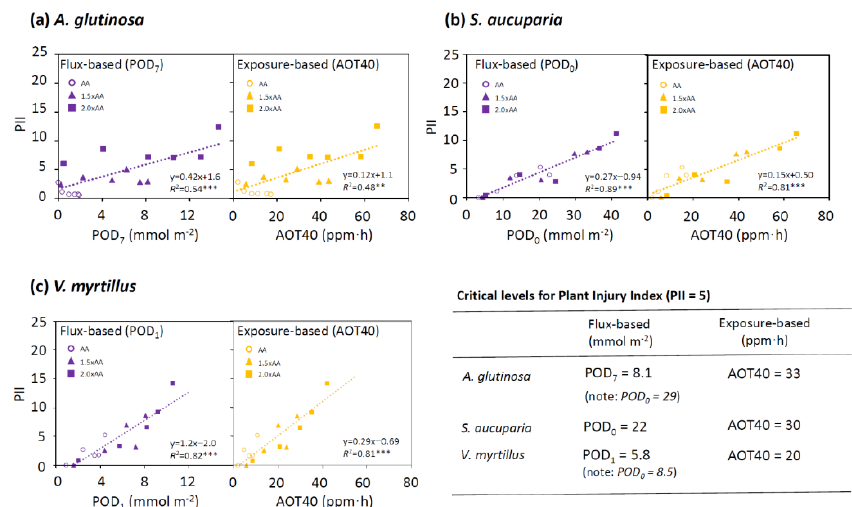
Figure 6. Dose-response relationships for plant injury index (PII) in Alnus glutinosa , Sorbus aucuparia , and Vaccinium myrtillus using two O 3 indices, POD Y (phytotoxic ozone dose above a flux threshold of Y nmol m − 2 s − 1 ) and AOT40 (accumulated exposure over a threshold of 40 ppb). The critical levels (CLs) corresponding to PII = 5 were also shown. Simple linear regressions were applied. *** p < 0.001 and ** p < 0.01.